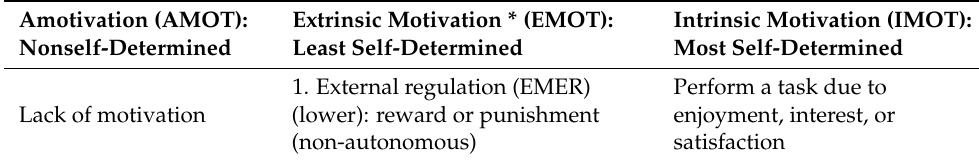
Table 1. SDT: amotivation, extrinsic motivation, and intrinsic motivation. Amotivation (AMOT):